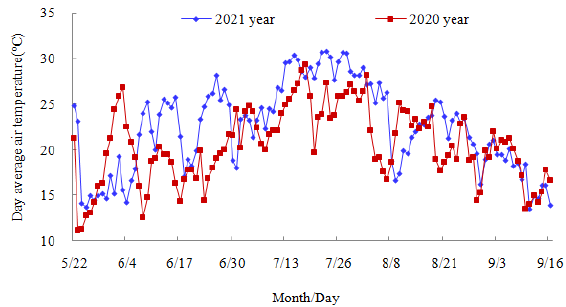
Figure 1. Changes in daily average air temperature during rice growing season in 2020 and 2021.